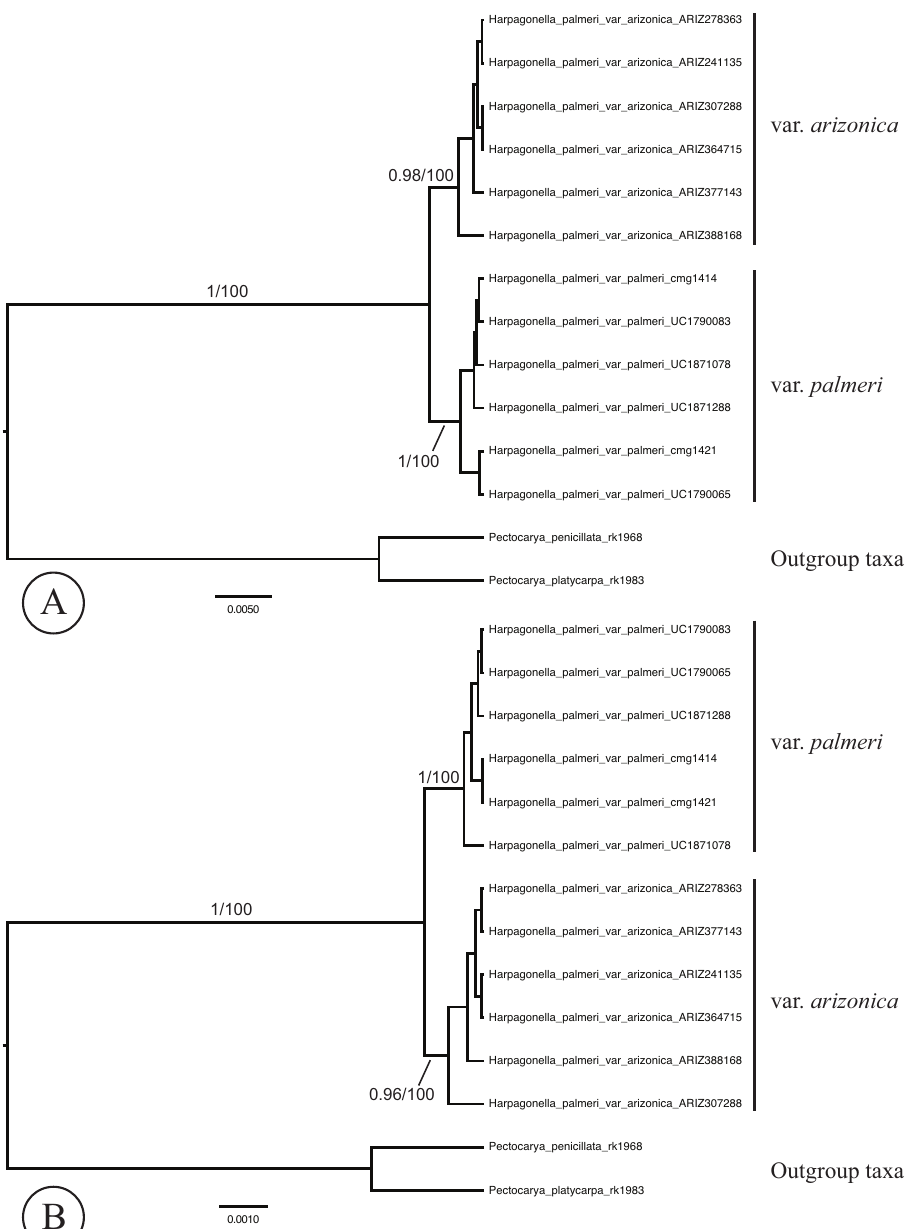
Figures 3. Maximum clade credibility trees from phylogenetic analysis of the: A combined, partitioned nuclear DNA regions, and B combined, partitioned chloroplast DNA regions. Values on branches are Bayesian posterior probabilities followed by maximum likelihood bootstrap